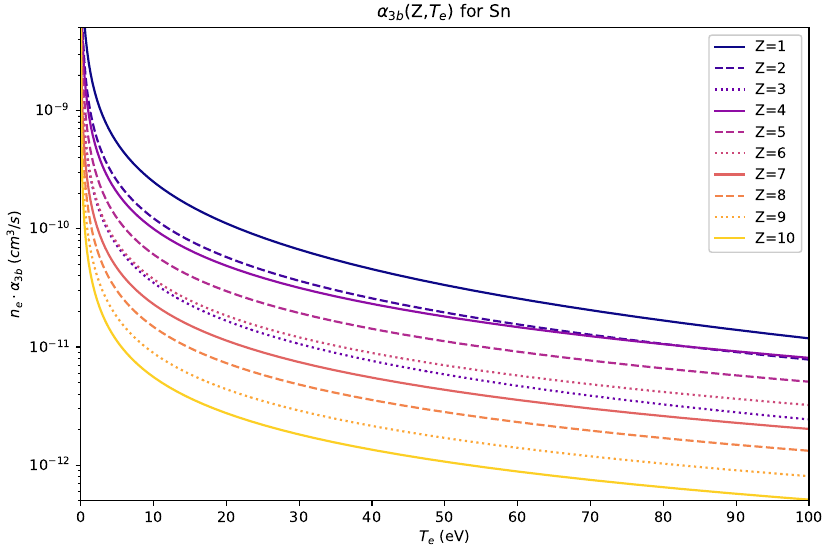
Figure 4. A plot of the 3-body recombination rate coefficient for Sn made with NIST χ included. Here the Sn 3 + curve is not in the same order of charge as the other curves, and is instead between the Sn 6 + and Sn 7 + curves. The Sn 2 + curve can also be seen crossing the Sn 4 +